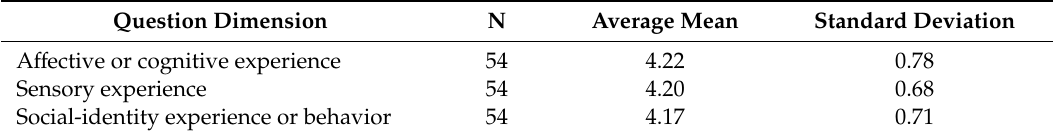
Table 20. Average scores of the evaluation of the writers’ experiences from indicator viewpoints. Question Dimension N Average Mean Standard Deviation A ff ective or cognitive experience